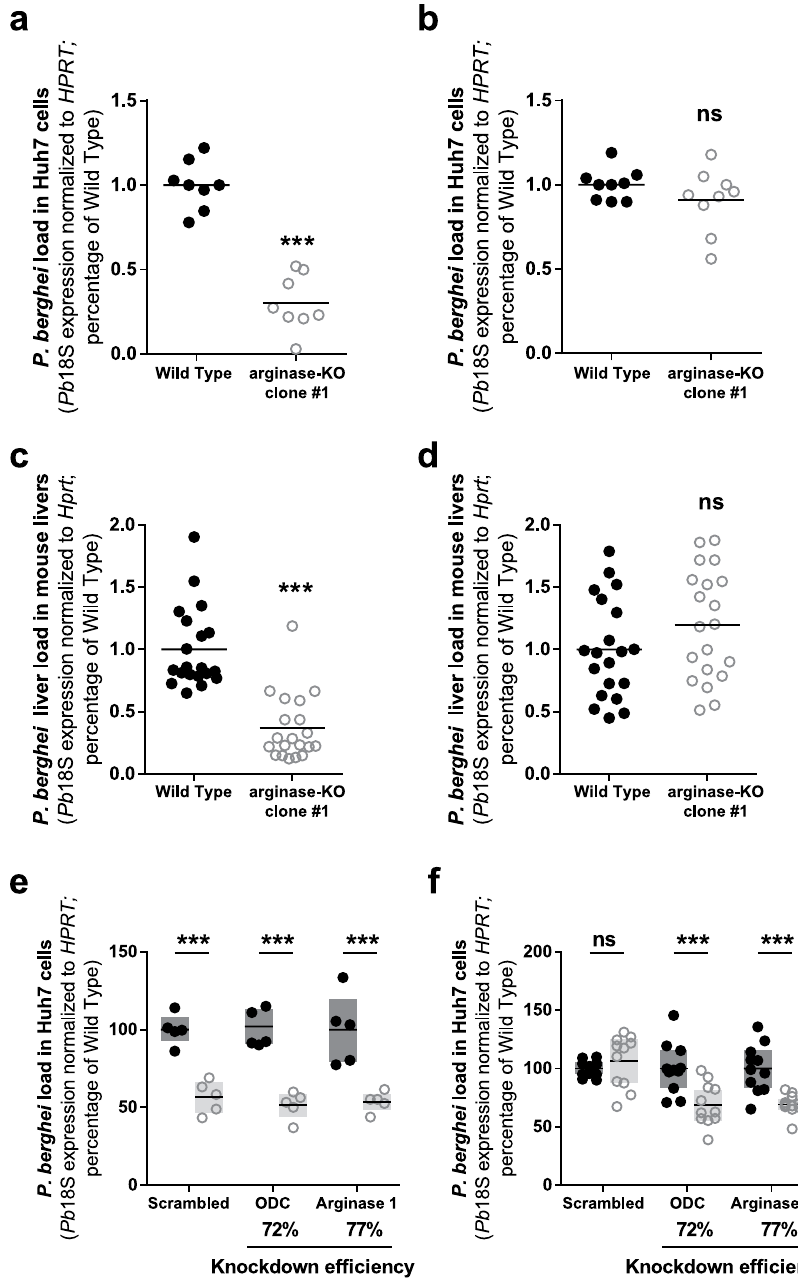
Figure 5. The arginase-KO parasite displays a bimodal hepatic infectivity both in vitro and in vivo , and can rely on the host polyamine synthesis pathway. ( a ) Huh7 cells were infected with WT and arginase-KO clone #1 P . berghei sporozoites and parasite load was assessed at 48 hpi by qPCR. In 6 out of 12 independent experiments, infection by the arginase-KO clone #1 parasite was reduced by 70%. ( b ) In the remaining 6 experiments, no difference was observed. ( c ) Mice were infected with WT and arginase-KO clone #1 P . berghei sporozoites and parasite liver load was assessed at 44 hpi by qPCR. In 4 out of 8 independent experiments, infection by the arginase-KO clone #1 was reduced by 65%. WT: n = 20 mice; arginase-KO: n = 20 mice. ( d ) In the remaining 4 experiments, no difference was observed. WT: n = 20 mice; arginase-KO: n = 20 mice. ( e ) Huh7 cells with or without the knockdown of host’s ODC and arginase 1 were infected with WT and arginase-KO clone #1 P . berghei sporozoites and parasite load was assessed at 48 hpi by qPCR. In the experiments in which the infection by the arginase-KO clone #1 parasite was already reduced relative to the WT control, no further decrease was observed upon ODC and arginase 1 knockdown. Pool of 2 independent experiments. ( f ) In the experiments in which the arginase-KO clone #1 parasite displayed a behavior similar to the WT parasite, ODC and arginase 1 knockdown led to a 30% reduction in parasite load. Pool of 3 independent experiments. ( a ) to ( d ) Two- tailed Mann-Whitney test. ( e ) and ( f ) Dots represent individual replicates. Two-way ANOVA with post-test Bonferroni. ns - not significant and *** p <